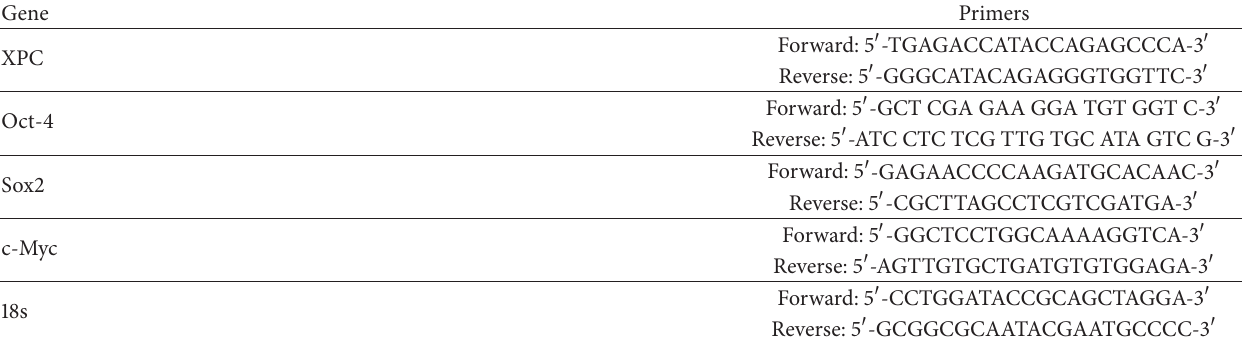
Table 1: Primer sequences used in quantitative real-time polymerase chain